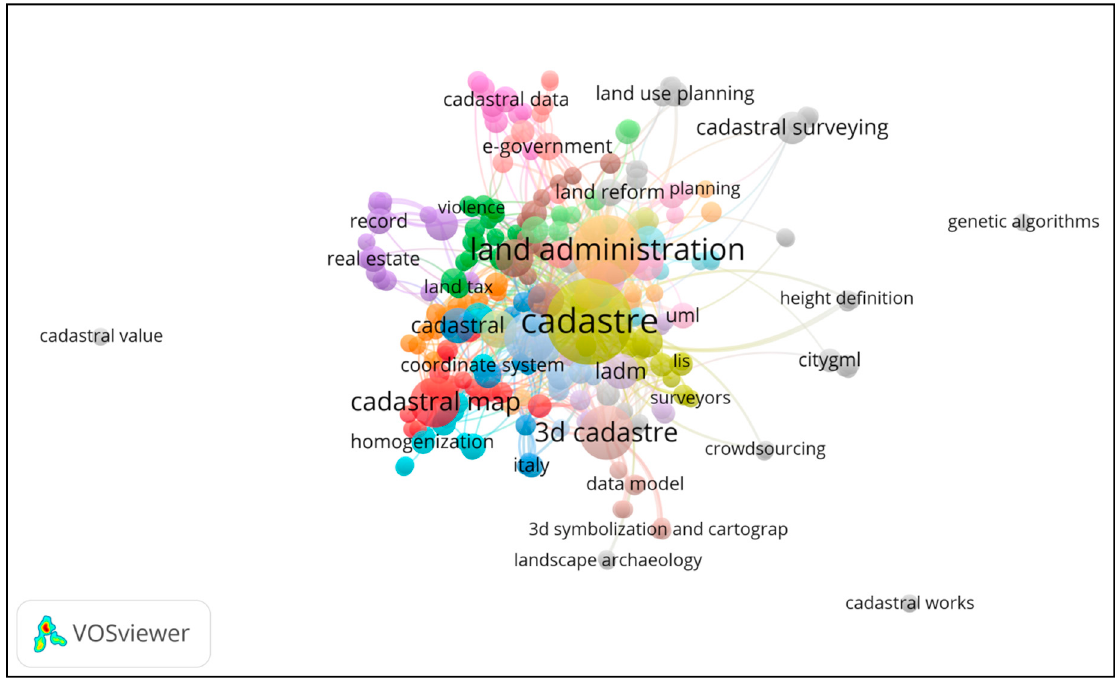
Figure 5. Keyword network map 2008–2014.